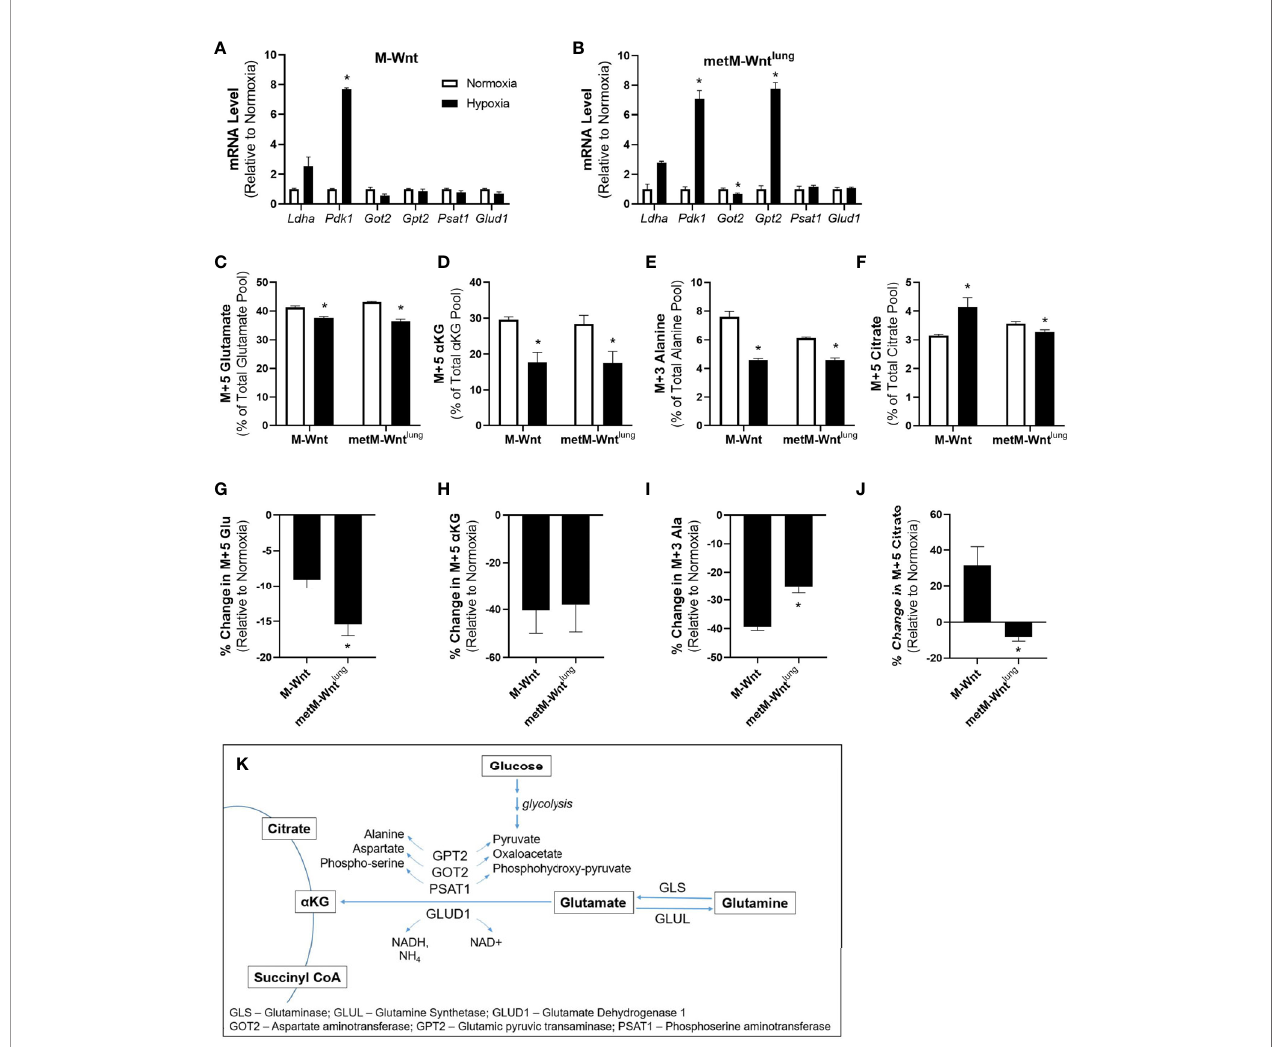
FIGURE 1 | Metabolic adaptation in hypoxia. Levels of genes involved in glucose and glutamine metabolism were analyzed by qRT-PCR in M-Wnt (A) and metM- Wnt lung (B) cells. Stably labeled 13 C 5 glutamine was used to determine metabolism to glutamate (C) , a -ketoglutarate (D) , and citrate (F) . Percent change in labeling of glutamate (G) , a -ketoglutarate (H) , and citrate (J) were determined relative to normoxia for each cell line. Stably labeled 13 C 6 glucose was used to determine metabolism of glucose to alanine (E) . Percent decrease in alanine labeling (I) was determined relative to normoxia for each cell line. Overview of glutamine and glucose metabolism (K) . Results are expressed as mean + SEM. Asterisk (*) indicates P < 0.05 relative to normoxia (A – F) or relative to M-Wnt (G – J) ;